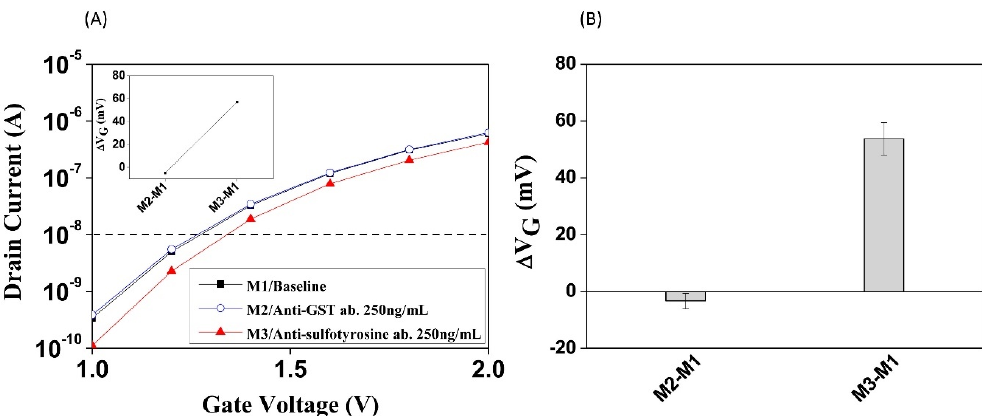
Figure 5. Electrical responses of the functionalized pSNWFET to synthesized sulfated PSGL-1 ( A ) I D -V G curve obtained from the synthesized sulfated PSGL-1 peptide and interaction with anti-sulfotyrosine, and anti-glutathione-S-transferase antibodies (anti-GST) as the controls. The measurement was conducted at a fixed drain voltage (V DS = 0.5 V), whereas the gate voltage sweeping rate was kept at 1–2 V to obtain the electrical property as the baseline (M1). The anti-GST antibody was used as a negative control (M2). Anti-sulfotyrosine antibody treatment (M3). The concentration of both antibodies was 250 ng / mL. ( B ) Average ∆ V G value of Figure 5A; the error bar indicates standard deviation. The average electrical responses were calculated from four devices for each condition, and Figure S3 illustrates other data of electrical response.